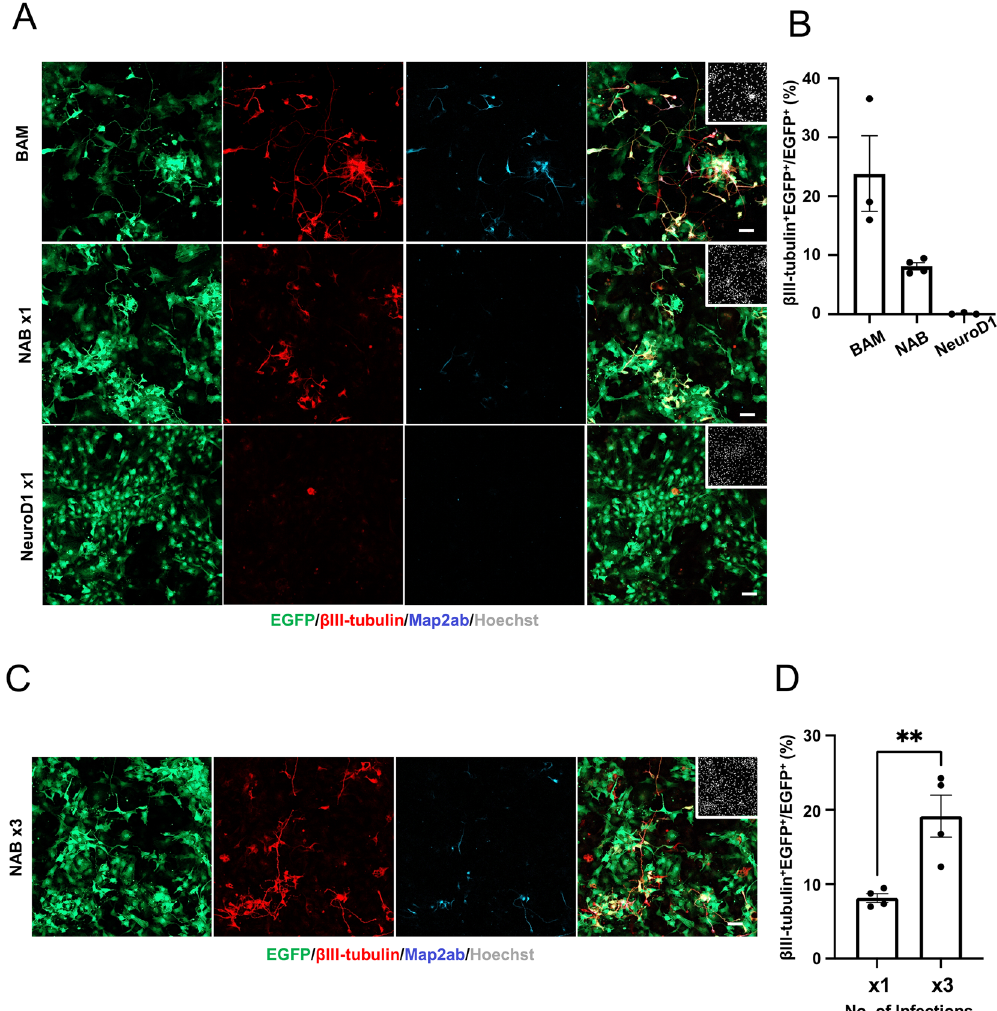
Representative images of staining for EGFP (green), βIII-tubulin (red), and Map2ab (cyan) in MEFs infected three times (× 3) with EGFP- and M2rtta-viruses together with NAB-viruses at 7 dpt. Dox, 1 μg/mL. Scale bar, 100 μm. ( D ) Quantification of βIII-tubulin and EGFP + cells in NAB-transduced MEFs at 7 dpt (n = 3). Data for single NAB-transduced MEFs were obtained from quantification of βIII-tubulin + and EGFP + cells in ( C ) (n = 3). Data for the single simultaneous infection (× 1) with EGFP-, M2rtta-, and NAB-viruses are the same as those (NAB) in (B). ** p < 0.005 by unpaired Student’s t